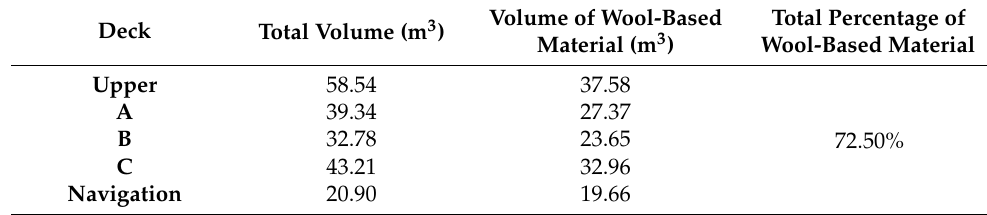
Table 2. Inventory analysis results of wool-based